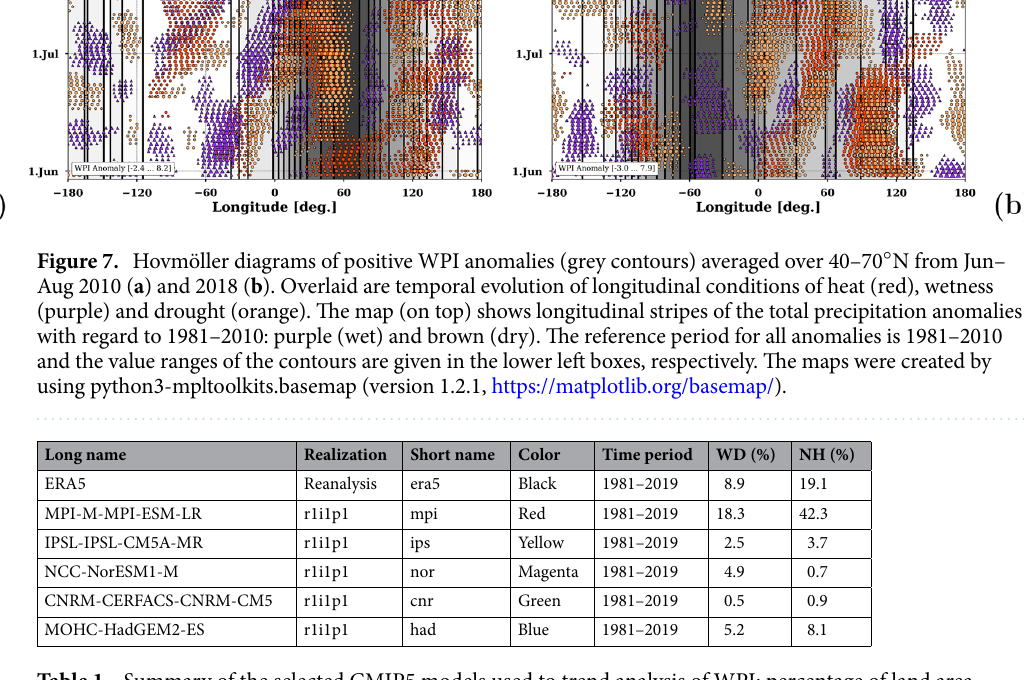
Table 1. Summary of the selected CMIP5 models used to trend analysis of WPI: percentage of land area showing positive trends of WPI in June–August of more than + 0.6dec above 30 ◦ N